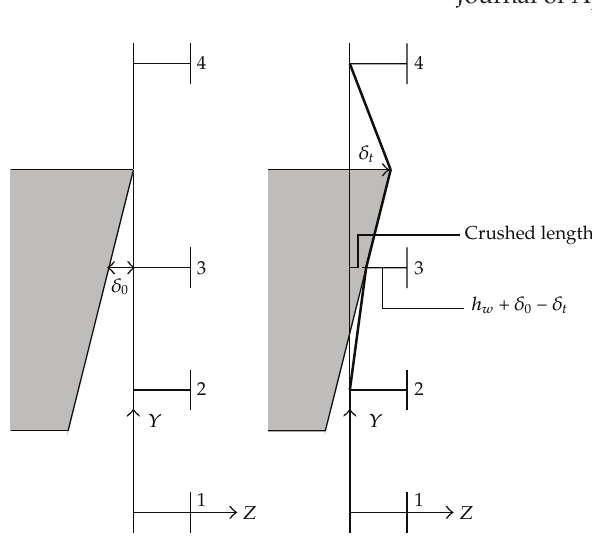
Figure 26: Combination of local and global deforming